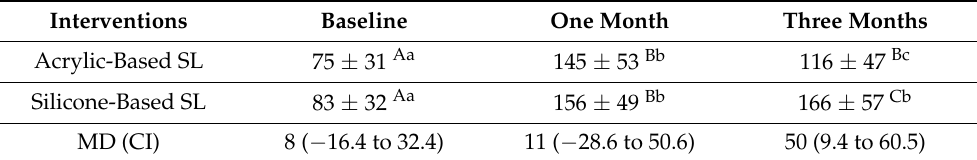
Table 4. Maximum bite force in Newtons (Mean ± SD) at baseline; 1, 2, and 3 months after den- ture adjustment. Interventions